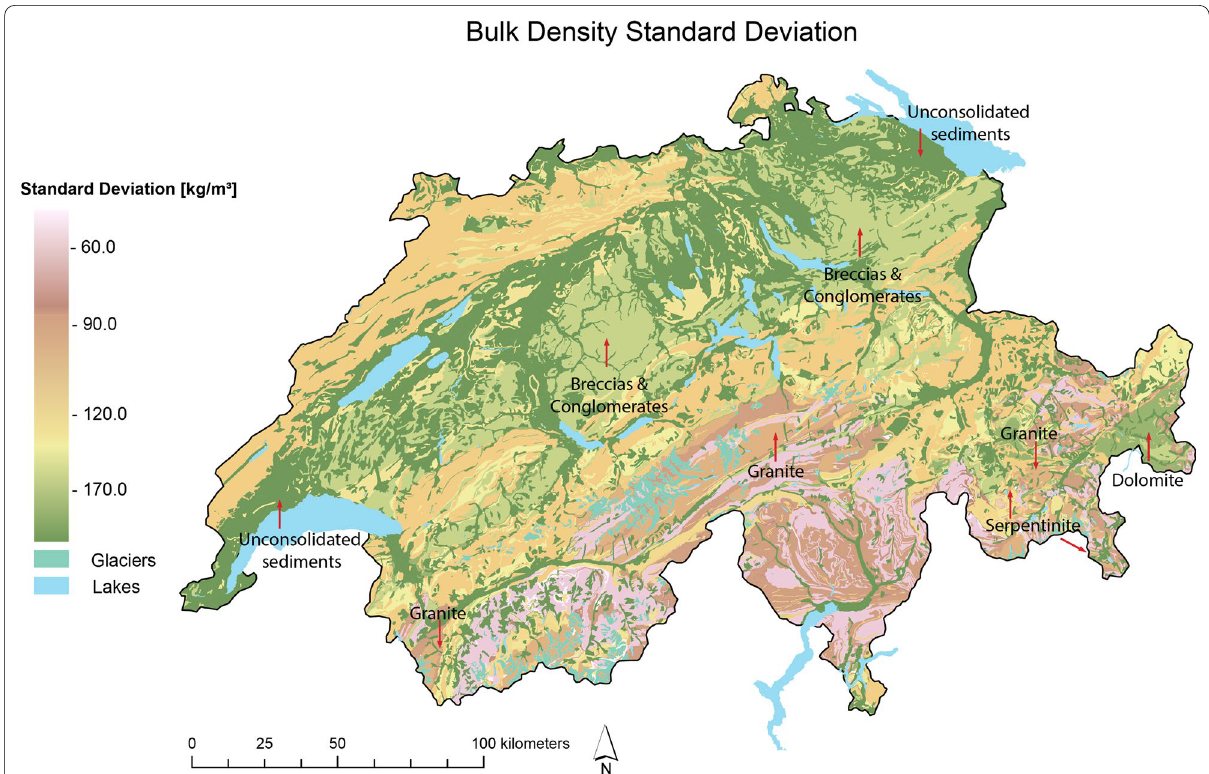
Fig. 13 Standard deviation of bulk density indicating the range of variability of density for each lithology group (see